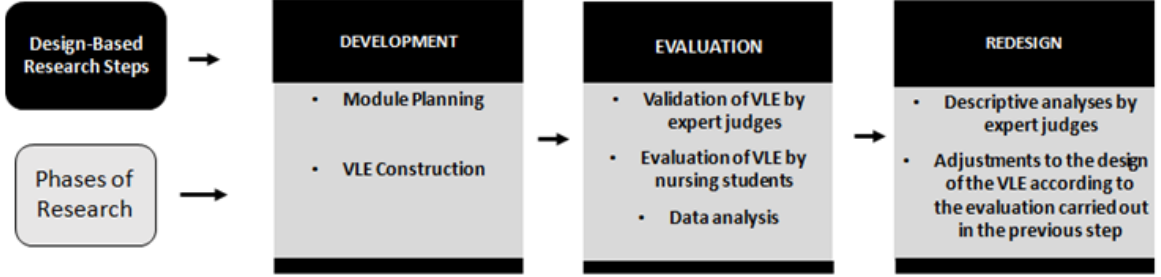
Figure 1. Research phases. VLE: virtual learning